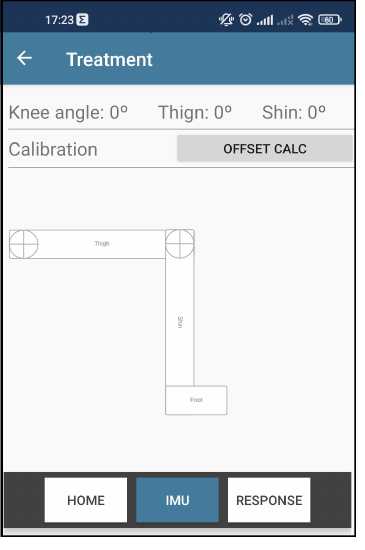
Figure 13. Knee angle recognition app